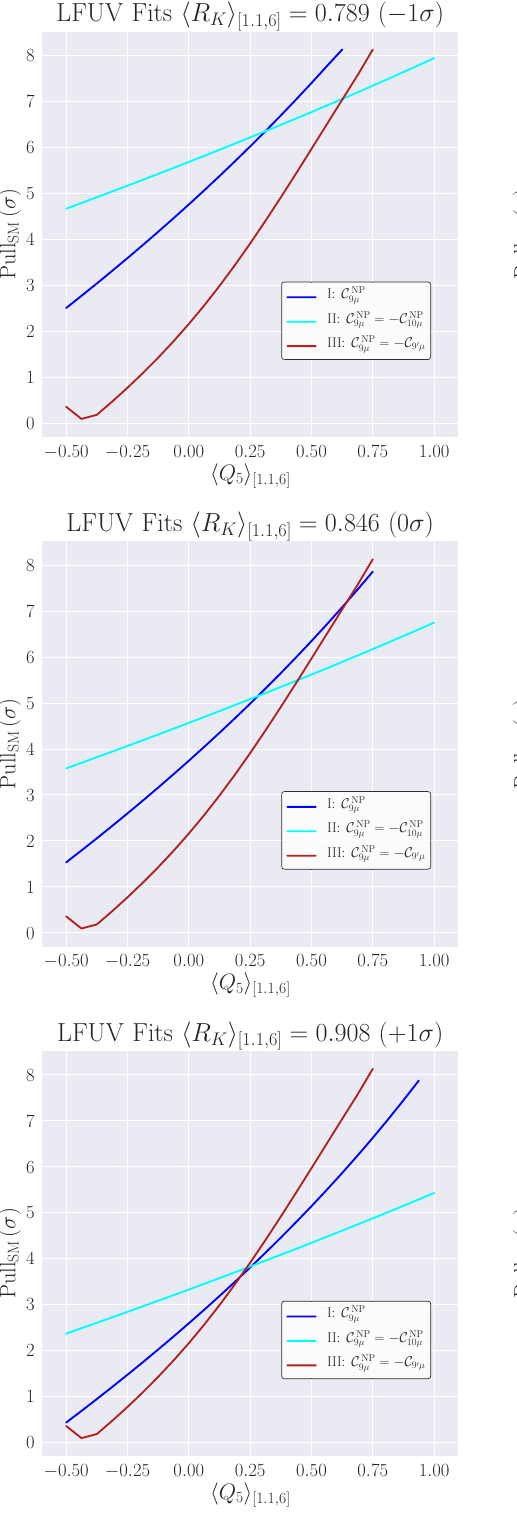
for different values of Q 5 (cid:31) (cid:30) [1 . 1 , 6]